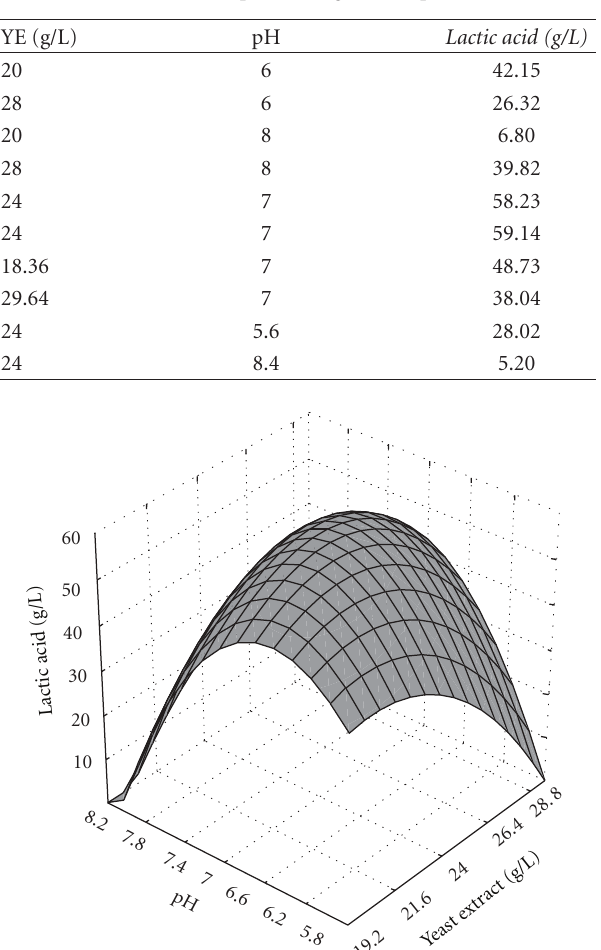
Table 4: New central composite design and experimental results.